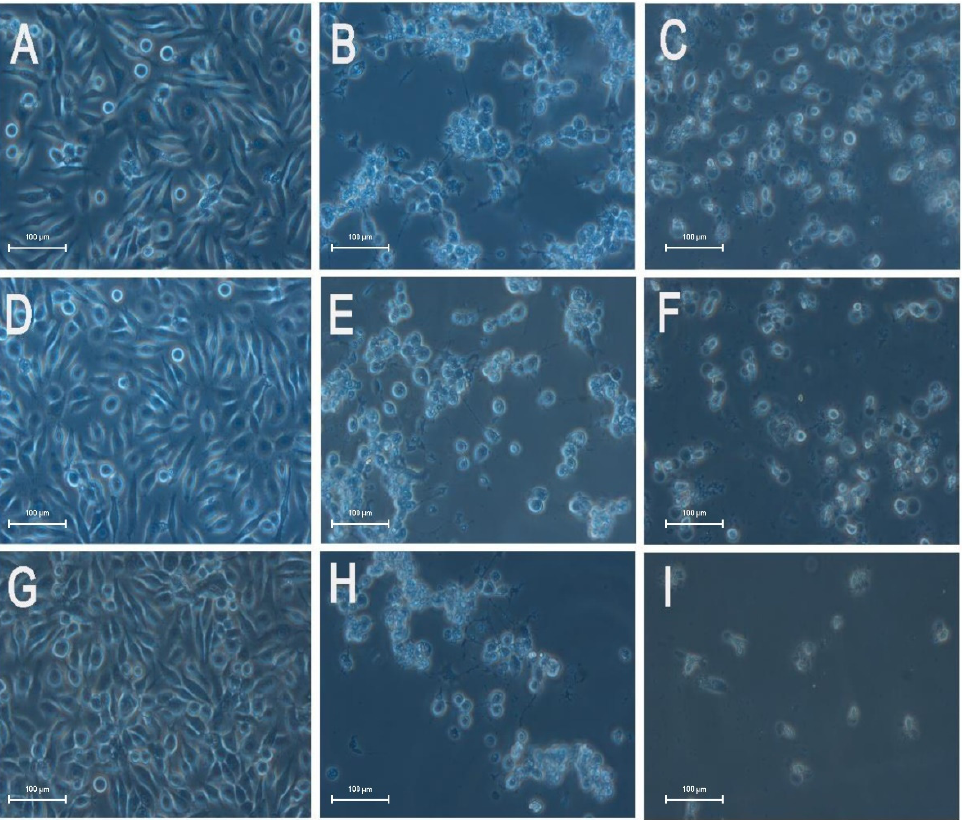
Figure 1. Observation of SL-1 cells treated with different concentrations of rotenone at different time points. Control: ( A ) 24 h, ( D ) 48 h, and ( G ) 72 h; 0.2 µg/mL of rotenone: ( B ) 24 h, ( E ) 48 h, and ( H ) 72 h; 20 µg/mL of rotenone: ( C ) 24 h, ( F ) 48 h, and ( I ) 72 h.